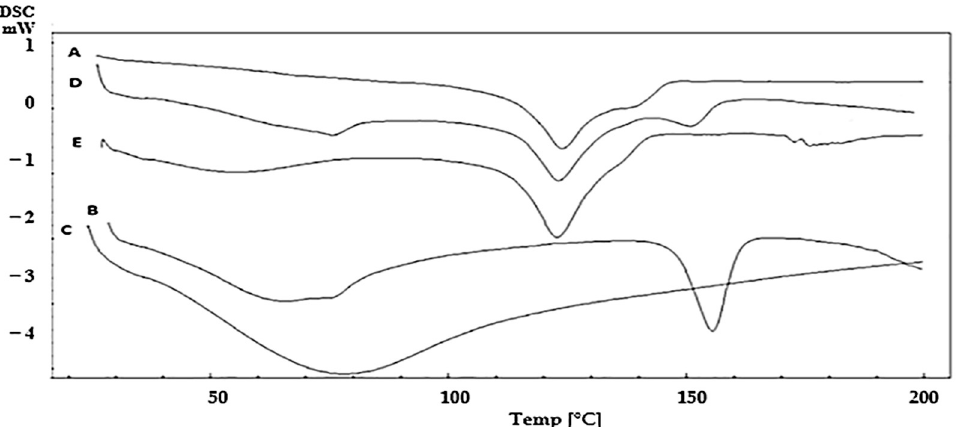
Figure 1. Differential scanning calorimetric (DSC) thermograms of ( A ) Paroxetine, ( B ) pectin, ( C ) CMC, physical mixture of Paroxetine with ( D ) pectin and ( E ) CMC.